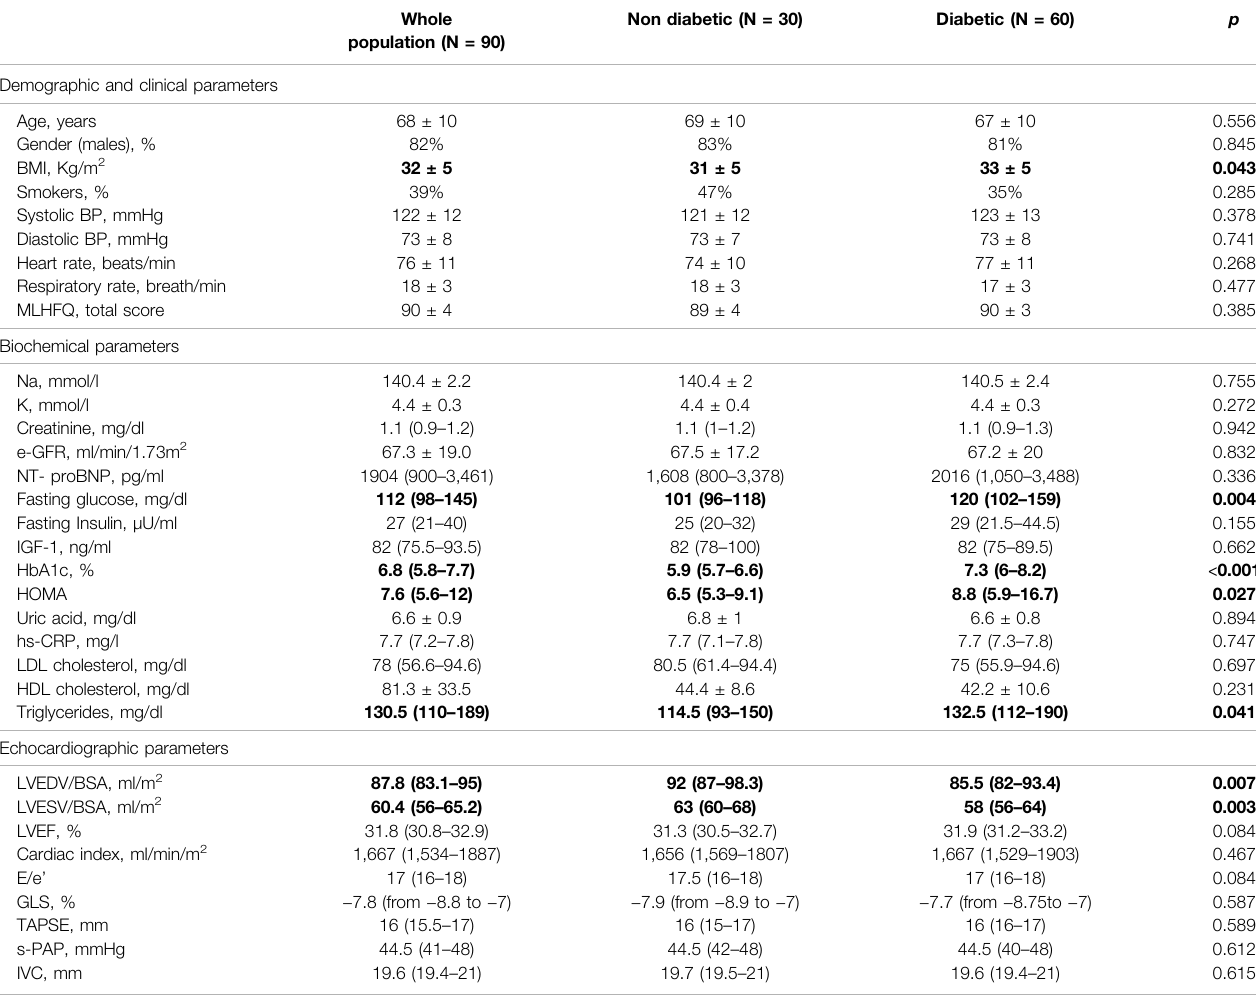
TABLE 1 | Baseline characteristics of patients that completed the study.